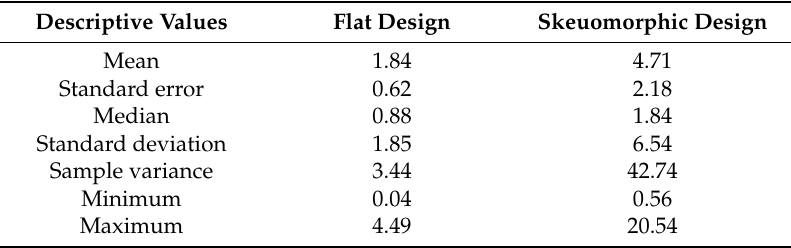
Table 3. Time to first